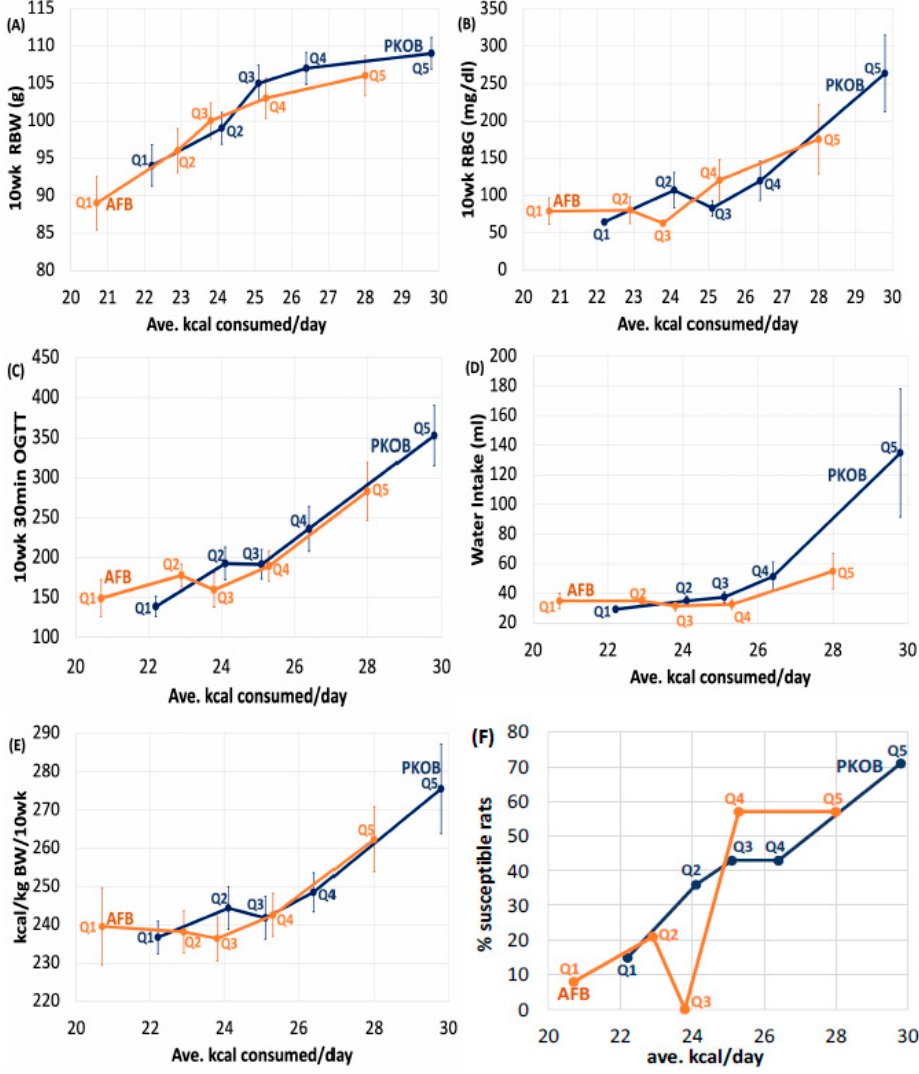
Figure 6. Clinical data for all rats fed either PKOB (blue) or AFB (orange) are expressed